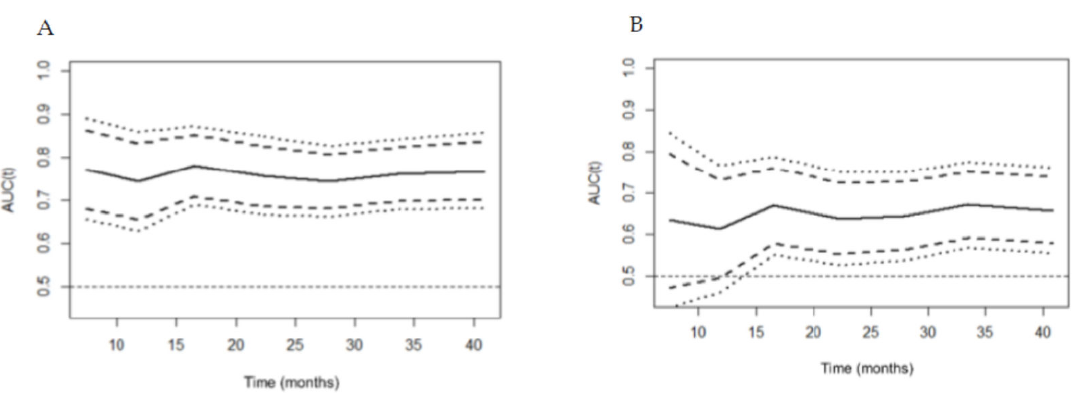
Figure 2. The curve of time-dependent area under the curve (AUC) for predicting the overall survival of the H6C score ( A ) and the model for end-stage liver disease (MELD) ( B ). The continuous line represents time-dependent AUC, and the dashed line and dotted line show 95% and 99% confidence internal, respectively. The AUCs of the H6C score were consistently higher than those of the MELD over